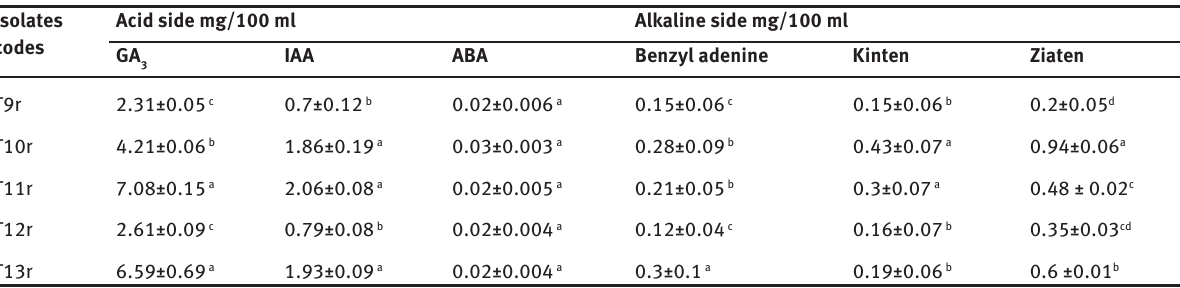
Table 5: Detection and quantification of various phytohormones (GA potent endophytic bacterial strains using HPLC